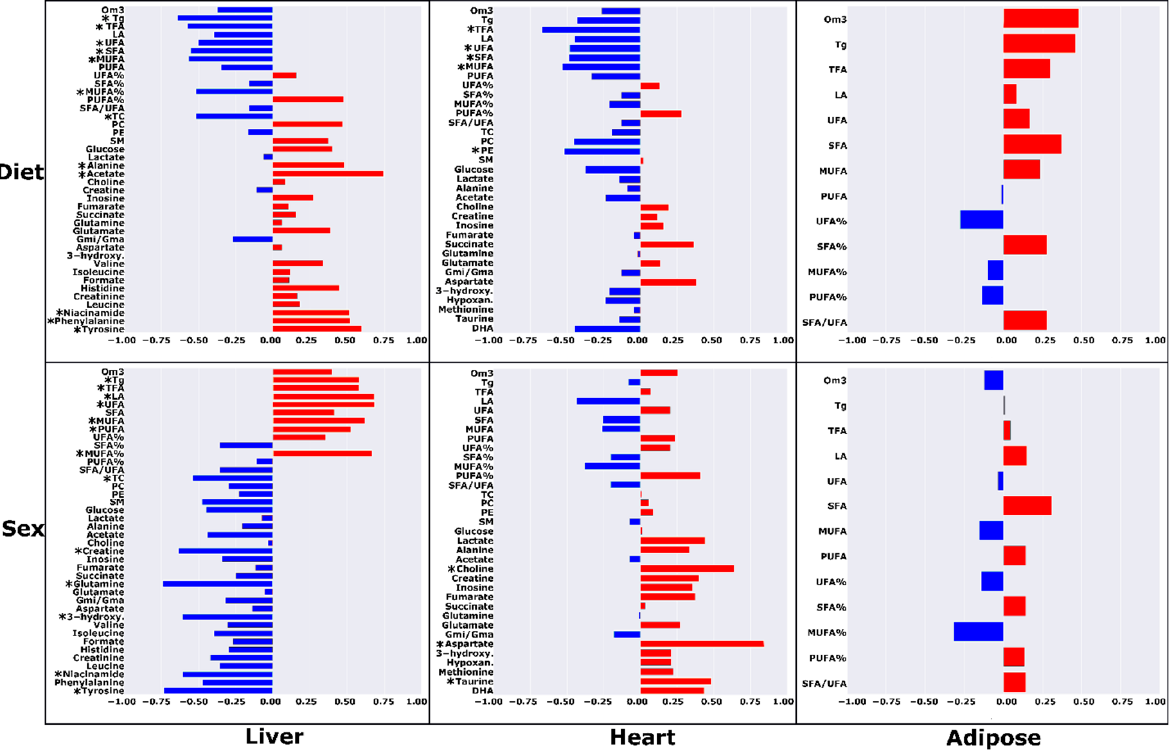
Figure 5. Correlations between metabolite concentration levels with diet and sex in high-fat ad libitum (HF-AD) and time-restricted morning (HF-AM) dietary groups. For dietary partial correla- tions, metabolites with negative coefficients are lower in HF-AM, and with positive correlation co- efficients are higher compared to HF-AD. For sex partial correlations, metabolites with positive correlation coefficients are higher in females, and vice versa for negative coefficients compared to males. The metabolites with significant partial correlations ( p < 0.05) are denoted with asterisks (*). Abbreviations: Tg = triglycerides; PC = phosphatidylcholine; SM = sphingomyelin; PE = phospha- tidylethanolamine; LA = linoleic acid; DHA = docosahexaenoic acid; MUFA = monounsaturated fatty acids; PUFA = polyunsaturated fatty acids; UFA = unsaturated fatty acids; SFA = saturated fatty acids; Om3 = omega-3 fatty acids; TFA = total fatty acids; TC = total cholesterol; 3-hydroxy. = 3-hydroxybutyrate; Hypoxan. = hyphoxanthine; Gmi/Gma = ratio of glutamine to glutamate.